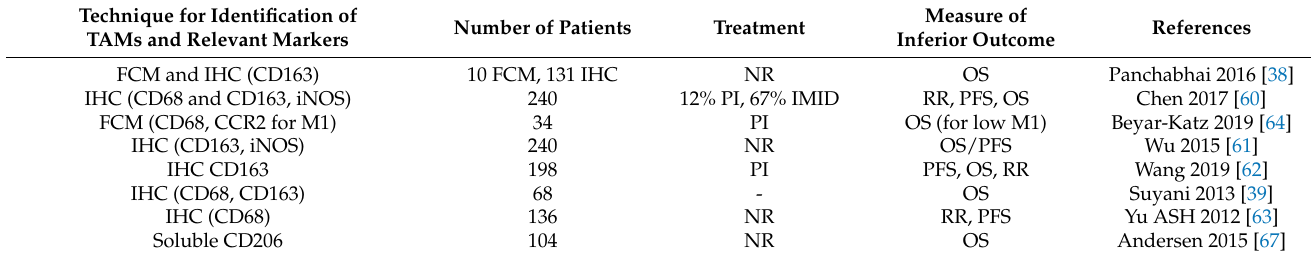
Table 2. Clinical studies implicating tumor-associated macrophages (TAM) as an adverse prognostic factor in MM; NR = not reported, PFS= progression-free survival, OS = overall survival RR = relapse rate. IHC = immunohistochemistry, FCM = flow cytometry, PI = proteasome inhibitor. Measure of Technique for Identification of Number of Patients Treatment Inferior TAMs and Relevant Markers